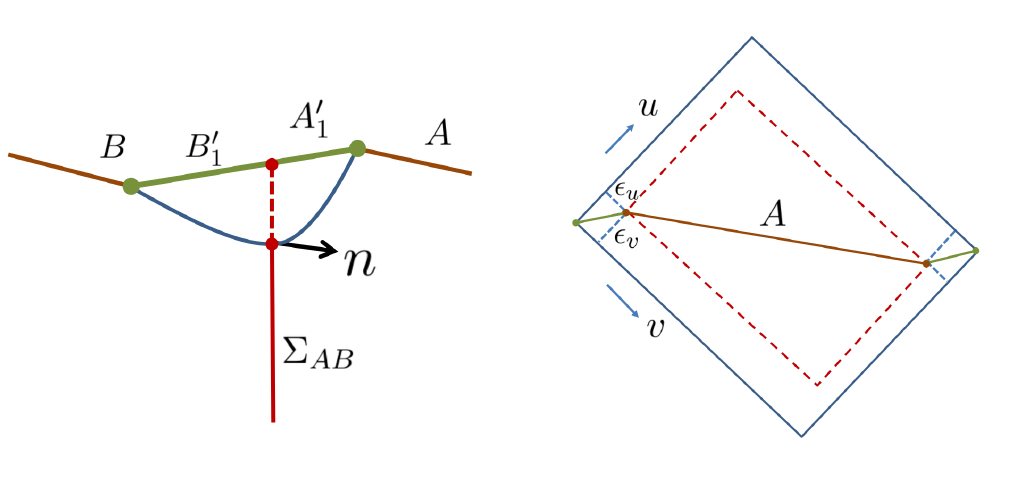
Figure 9: Left: The blue line is the RT surface E Σ which is normal to E AB wedge in the Rindler space with cutoffs ε